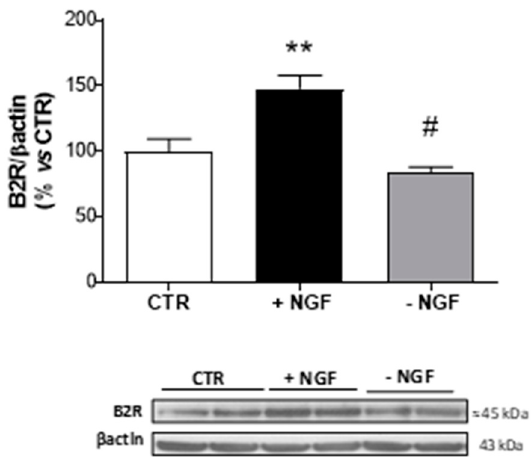
Figure 2. Expression of B2R after NGF treatment and deprivation in CNs. At 10 DIV, CNs cultured in Neurobasal + 1% B27 (CTR) were treated for 48 h with NGF (100 ng/mL, +NGF) before being deprived of NGF by anti-NGF antibody treatment and incubated for 24 h ( − NGF). B2R protein expression was measured by Western blot analysis. The immunoreactive signals at 45 kDa were quantified and normalized against β -actin and expressed as a percentage of the control (CTR). Data represent means (±S.E.M.) from four independent experiments run in duplicate. Statistically significant differences were calculated by one-way analysis of variance (ANOVA) followed by Bonferroni’s test for multiple comparisons (** p < 0.01 versus CTR; # p < 0.01 versus NGF treatment).